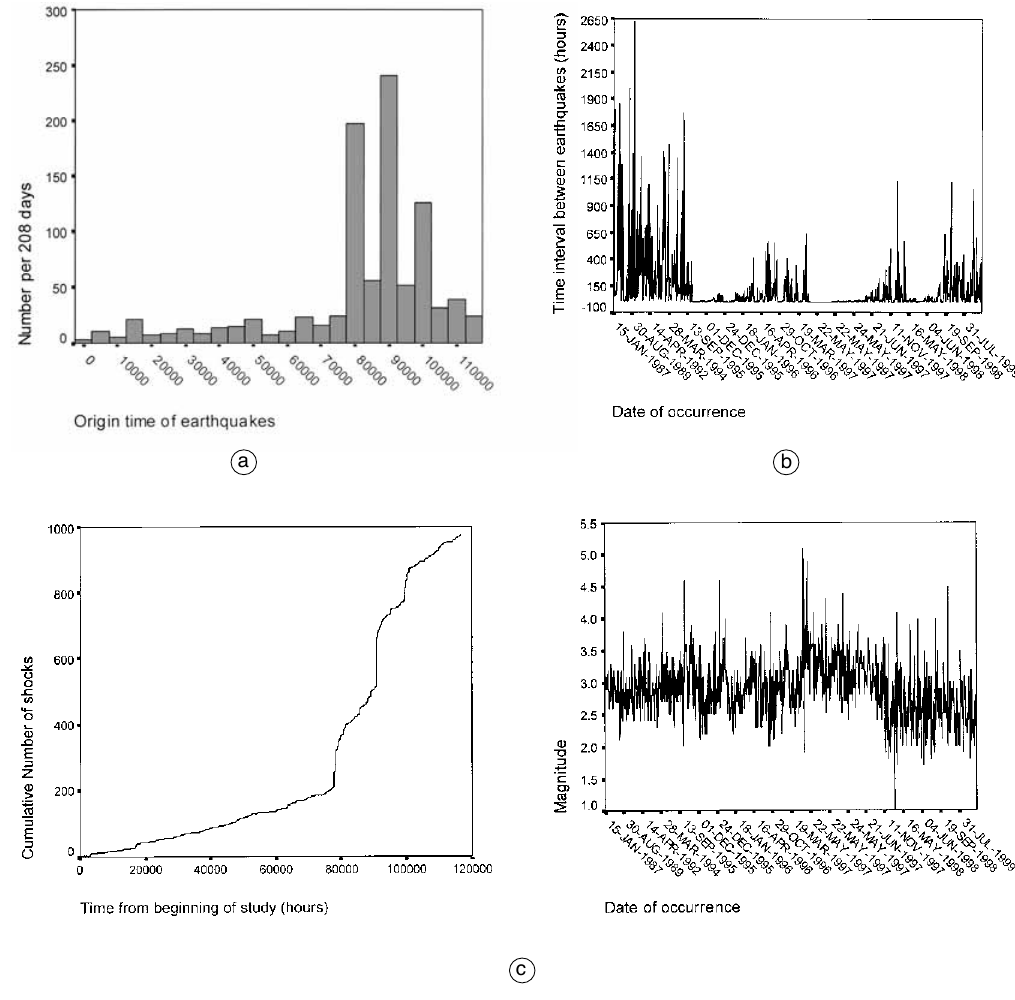
=1978 , number of shocks per 208 days; b) sequence graph of time } i i =1977 ; c) cumulative number of shocks with sequence graph of } i i